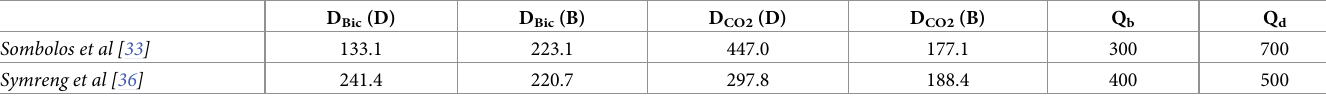
Table 3. Dialysances calculated from measured inlet and outlet dialyzer concentrations in published